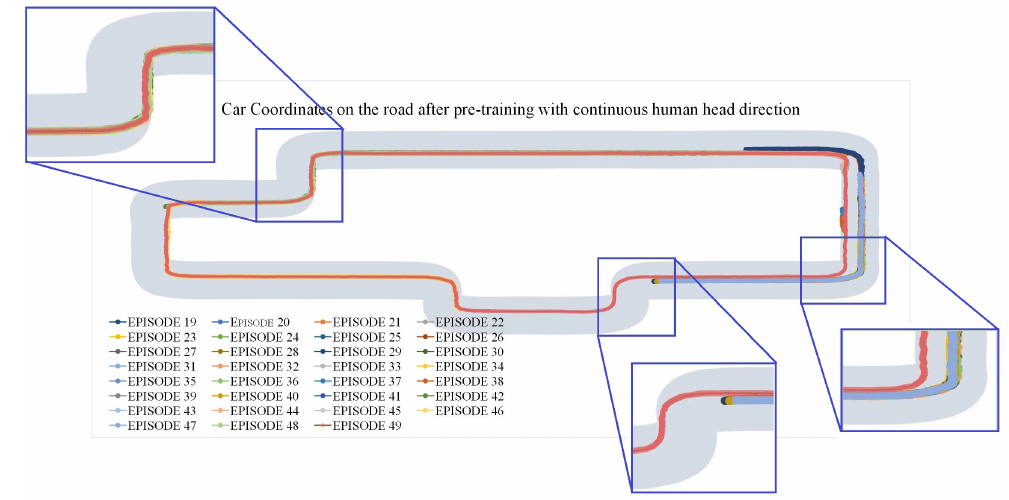
Figure 10. SAC + Continuous Head Direction Feedback: the car’s trajectory on the roadway after pre-training the SAC by 5000 steps of continuous human head direction feedback. Three zoomed-in overlays show details of some busy parts of the